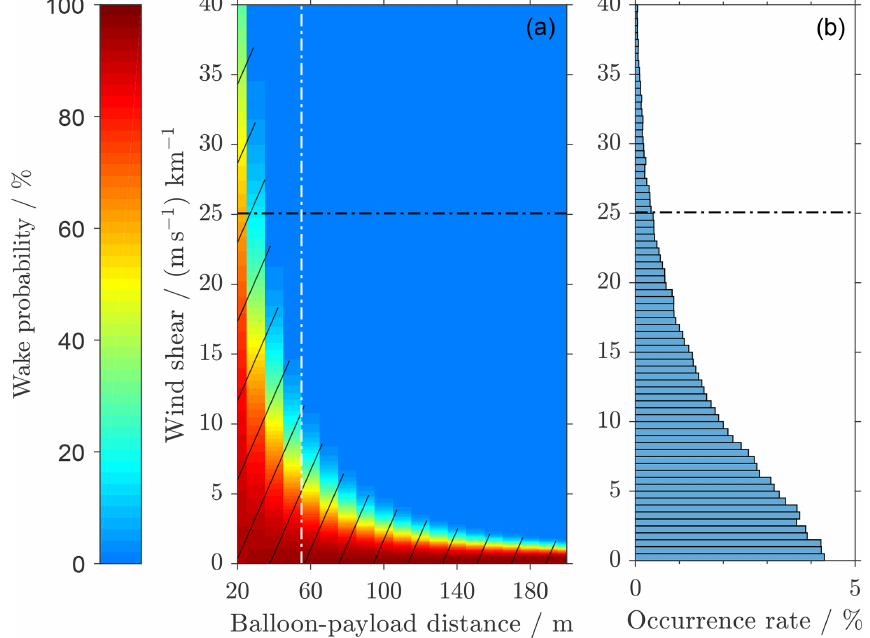
Figure 6. Wind shear influence on the wake probability P wake (no wind rotation, relative vertical balloon velocity w rel : 5ms − 1 ). The 95th percentile of the measured wind shear is indicated by the black dashed–dotted line. (a) Wake probability as a function of the magnitude of the wind shear and payload–balloon distance d p-bal . The white line denotes the horizontal balloon gondola distance for the RS41 radiosonde; the hatched area is potentially affected by the balloon’s wake ( P wake > 5%). (b) Wind shear from the 30 radiosonde observations described in Sect.